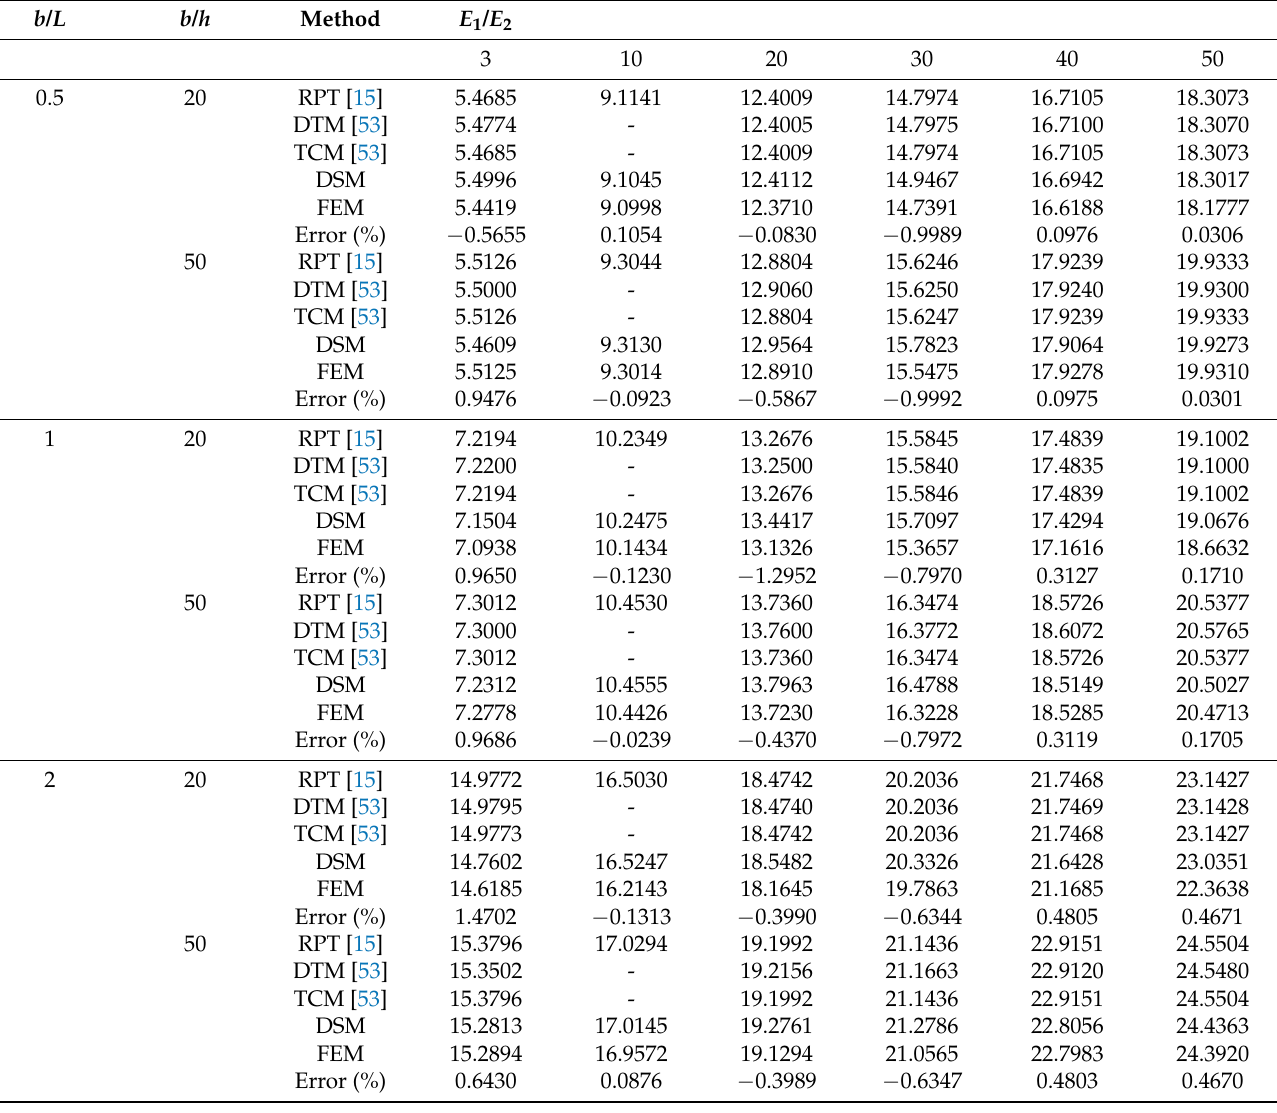
(cid:113) ρ (cid:16) (cid:17) (cid:118) = ω b 2 of the orthotropic E 2 h